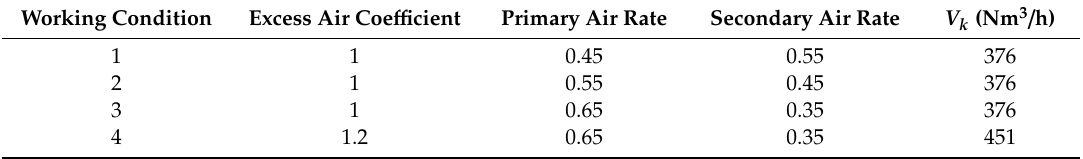
Table 4. Pilot test combustion tissue distribution and theoretical calculation of air